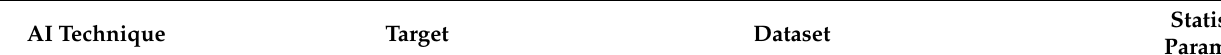
Table 5. Main examples of AI/ML in